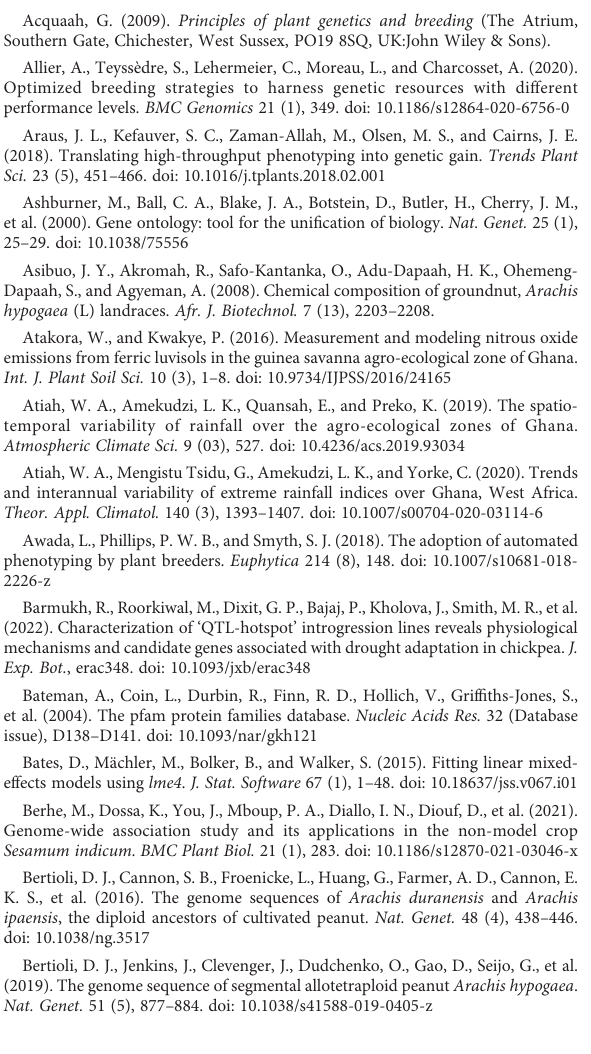
SUPPLEMENTARY FIGURE 3 Heatmap of the genomic kinship matrix obtained by the VanRaden (2008) Method among the single nucleotide polymorphism markers and 294 groundnut